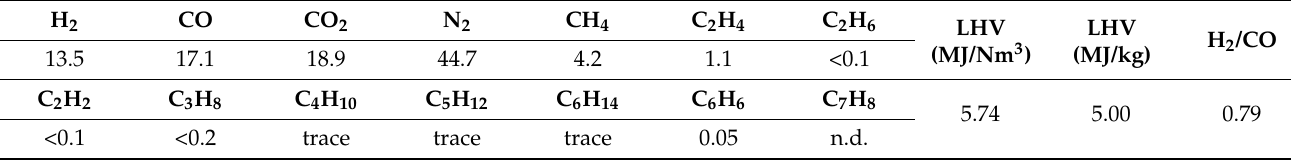
Table 6. Composition (% v / v ) and LHV of the experimentally produced syngas.